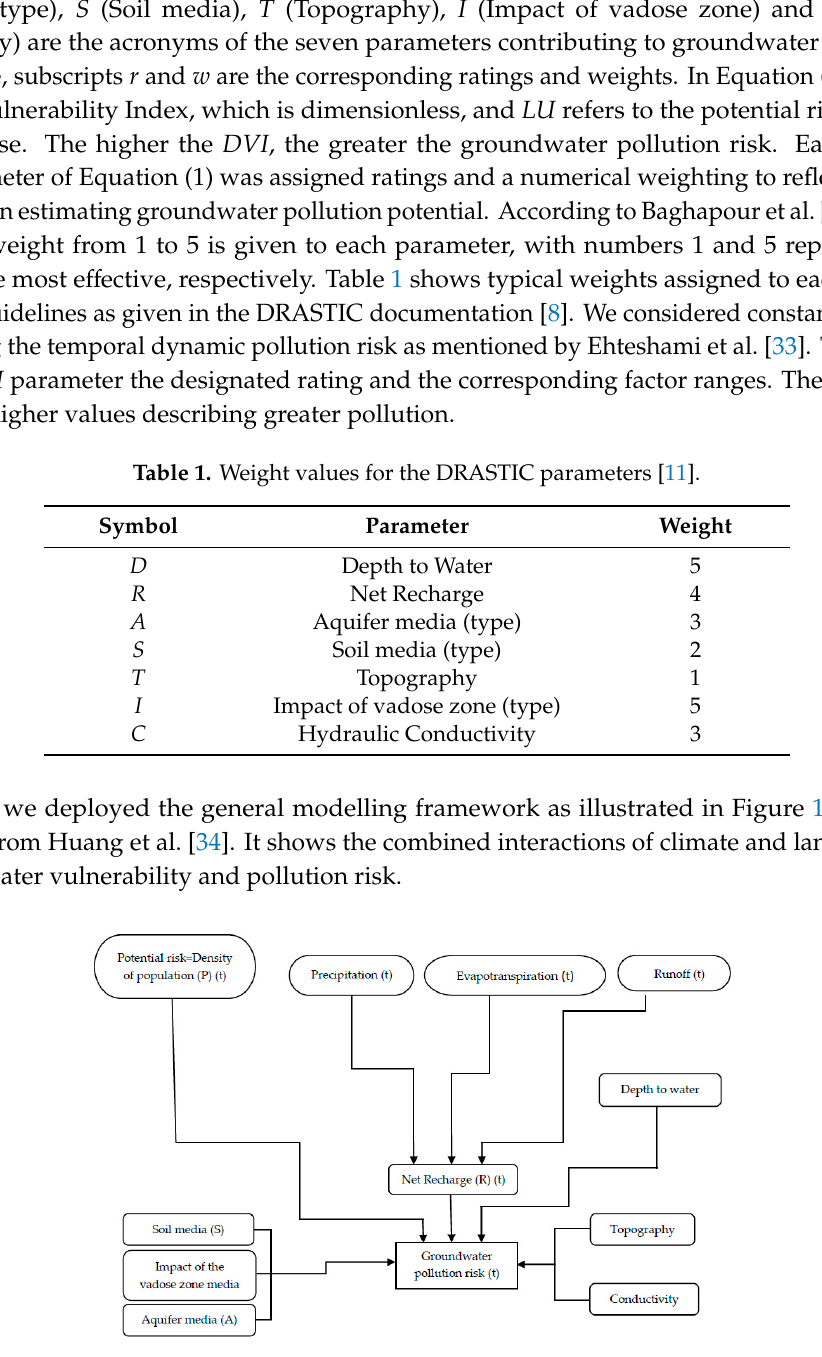
Figure 1. Impact of climate change, land use change, and environmental factors on groundwater (modified from [34]).